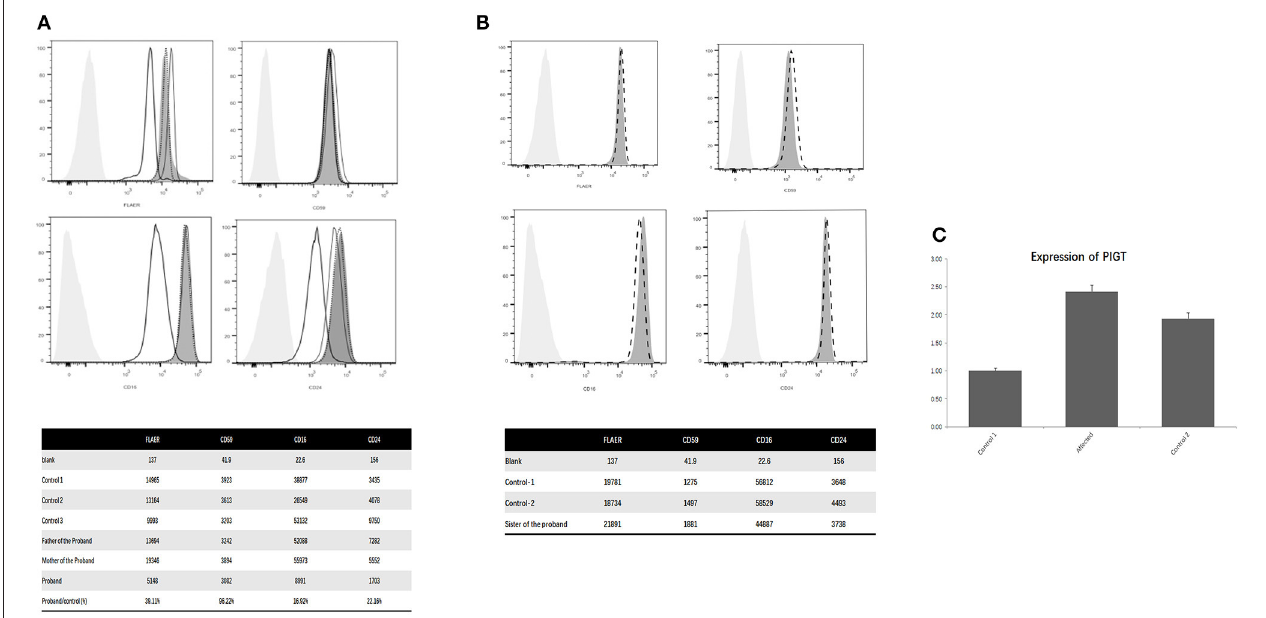
FIGURE 2 | (A) Flow cytometry of the proband, parents and controls; (B) Flow cytometry of the old sister of the proband and the controls; (C) PIGT mRNA expression on PBMCs. (A) The abscissa indicates the intensity of the fluorescence, the ordinate indicates the number of cells, the light gray shade represents the blank control, the dark gray shade represents the normal control, the black thick line represents the patient, the black fine line represents his mother, the black dotted curve represents his father. Shown that the expression of total GPI anchoring molecules in this patient was reduced to 39.11% of the normal controls. The expression of CD59 of the proband was similar with the normal controls. The expression of CD16 was reduced to 16.92% of the normal control and the expression of CD24 was reduced to 22.16%. Meanwhile, the abundance of the same proteins in the leucocytes of his parents was normal. (B) Shown that the level of CD16, CD24 and CD59 of the old sister (the dotted line) of the proband had no significant difference with the normal controls (The dark gray shades). (C) The level of PIGT mRNA on PBMCs of the proband was significantly higher than the two healthy controls (C)